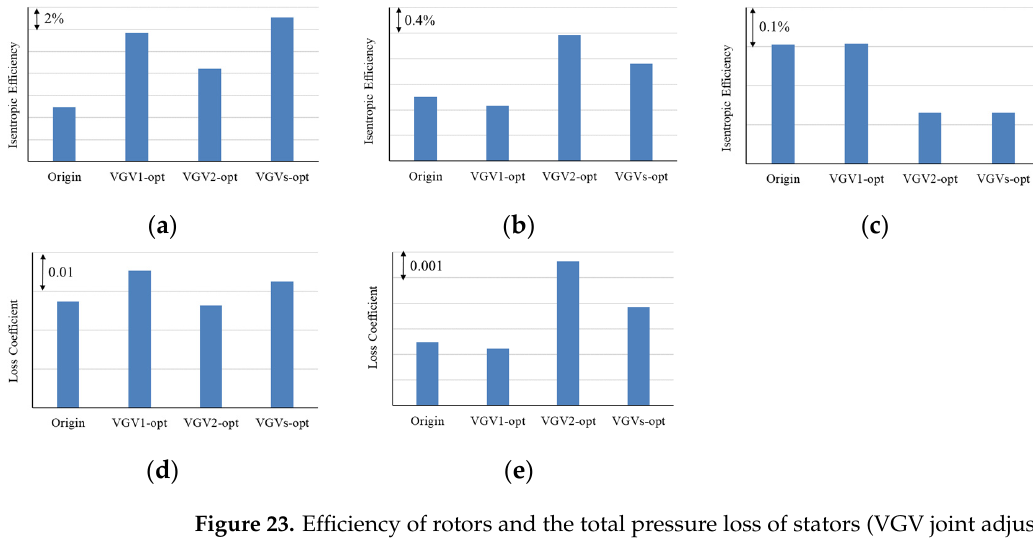
Figure 23. Efficiency of rotors and the total pressure loss of stators (VGV joint adjustment). ( a ) R1; ( b ) R2; ( c ) R3; ( d ) S1; ( e ) S2.